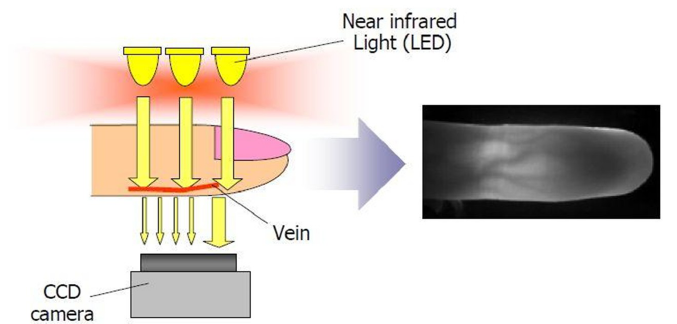
Figure 3. How a finger vein scanner works [27].